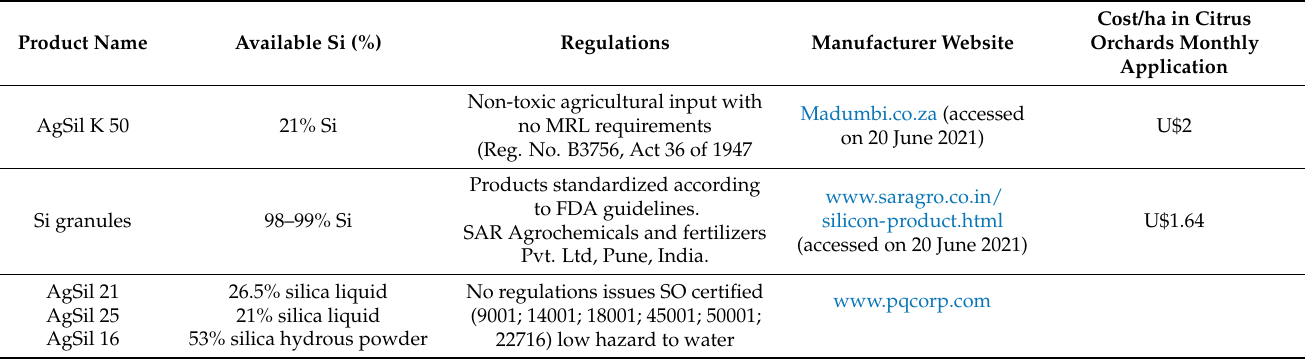
Table 1. Silicon fertilizer products